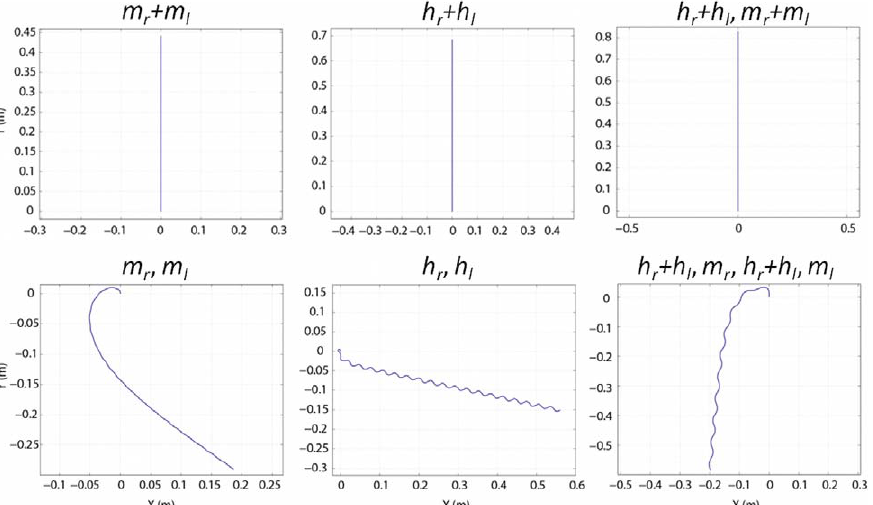
Figure 6. Net forward trajectories from swimming simulations. As indicated above each frame, the beating patterns that generated a true linear path were those where the right and left middle legs ( m r + m l ), hind legs ( h r + h l ), and hind followed by middle legs ( h r + h l , m r + m l ) beat simultaneously. In these three cases, the total distance traveled was equal to D y. For the other three cases where the middle right and left legs ( m r , m l ) and the hind right and left legs ( h r , h l ) beat alternately, and the simultaneous beating of the hind legs followed by the beating of a middle leg ( h r + h l , m r , h r + h l , m l ) the net forward distance traveled was calculated from a line between the start and end point. Numerical analysis of these trajectories is shown in Table 4